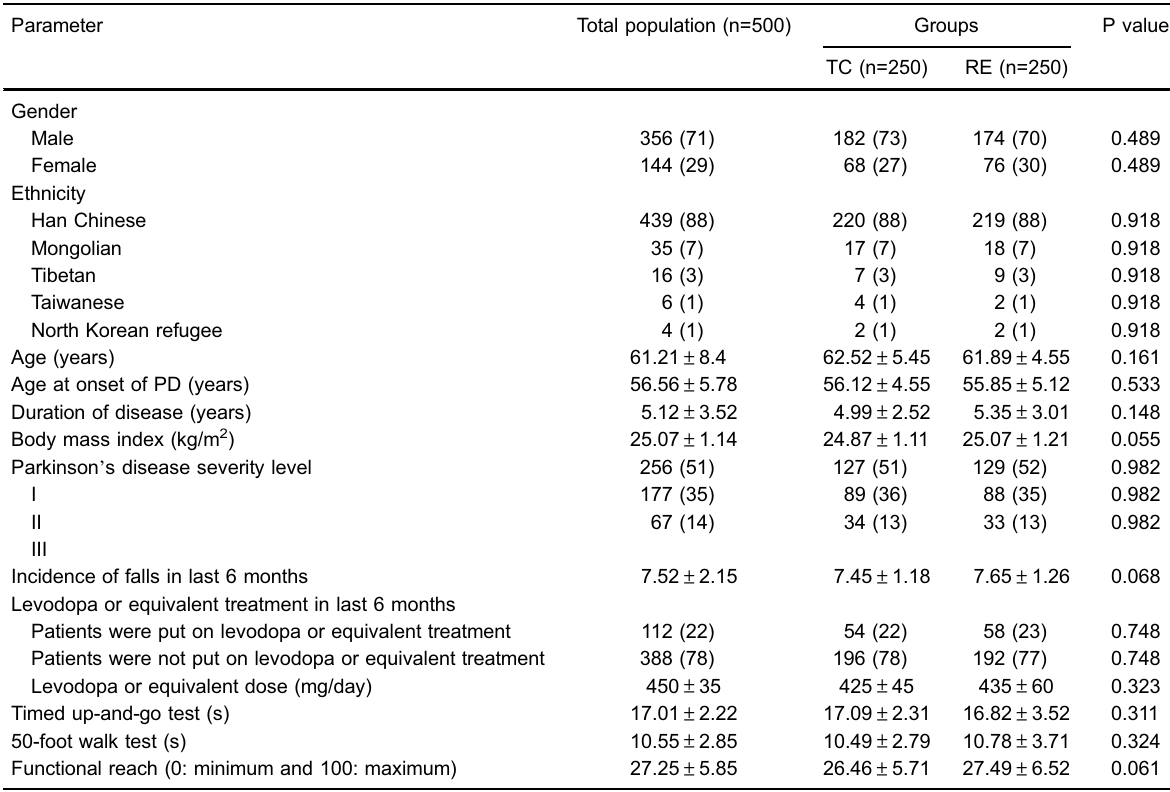
Table 1. Demographical, anthropological, and clinical parameters of the enrolled Parkinson ’ s disease patients who performed Tai Chi (TC) or routine exercise (RE) programs.